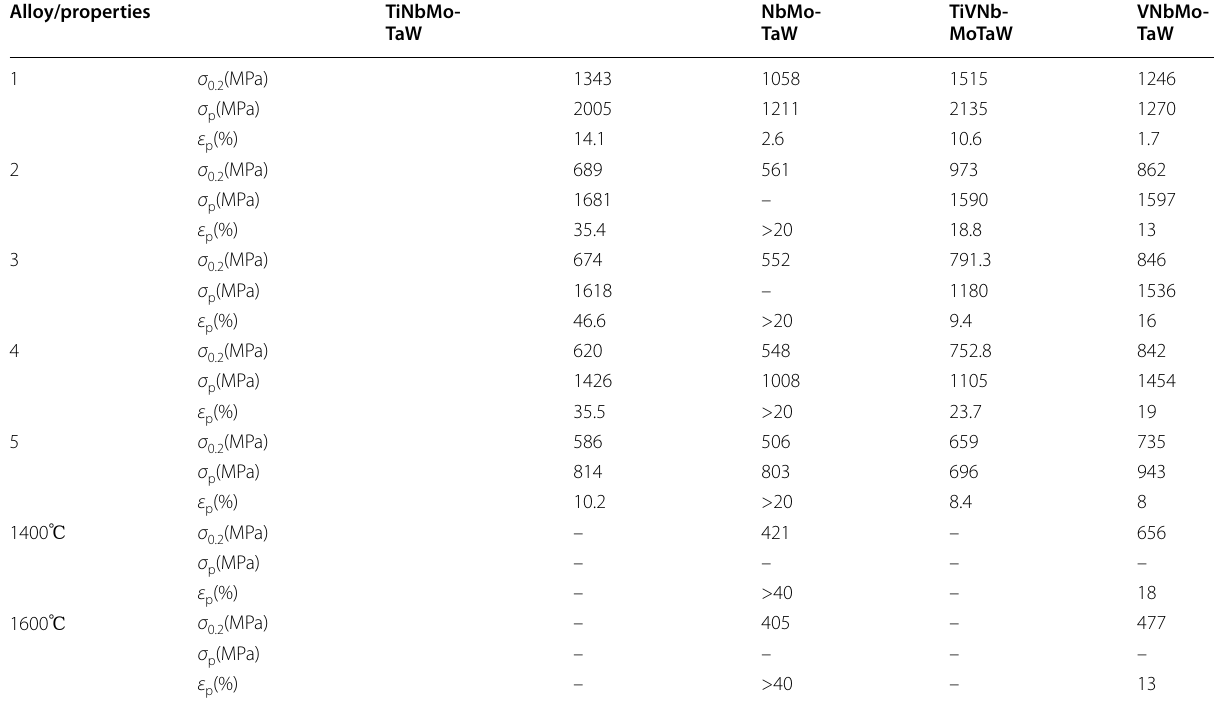
Table 1 Yield strength, peak strength and plastic strain at different temperatures of the TiNbMoTaW, NbMoTaW, TiVNbMoTaW and VNbMoTaW HEAs [31, 32]